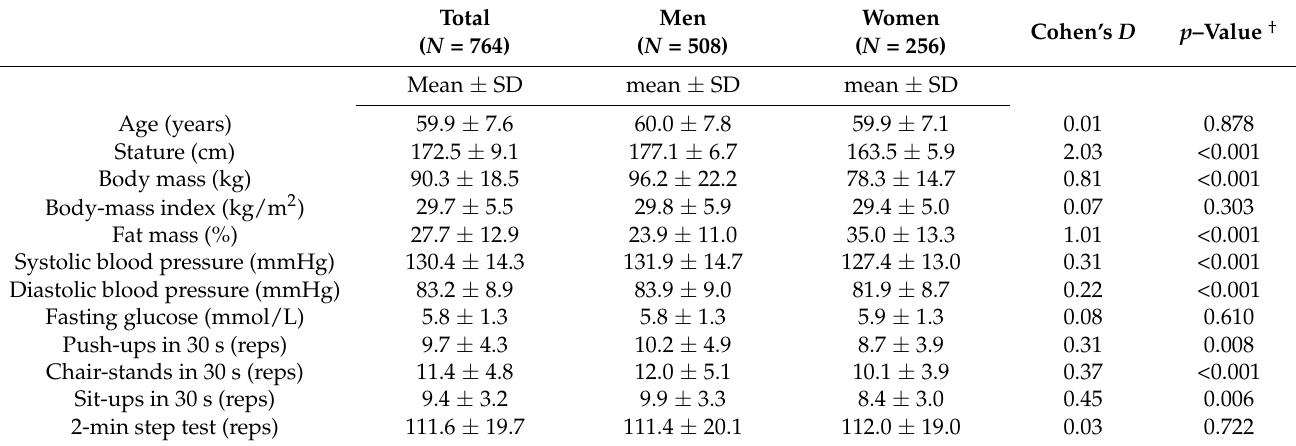
Table 1. Basic descriptive statistics of the study participants ( N = 764).